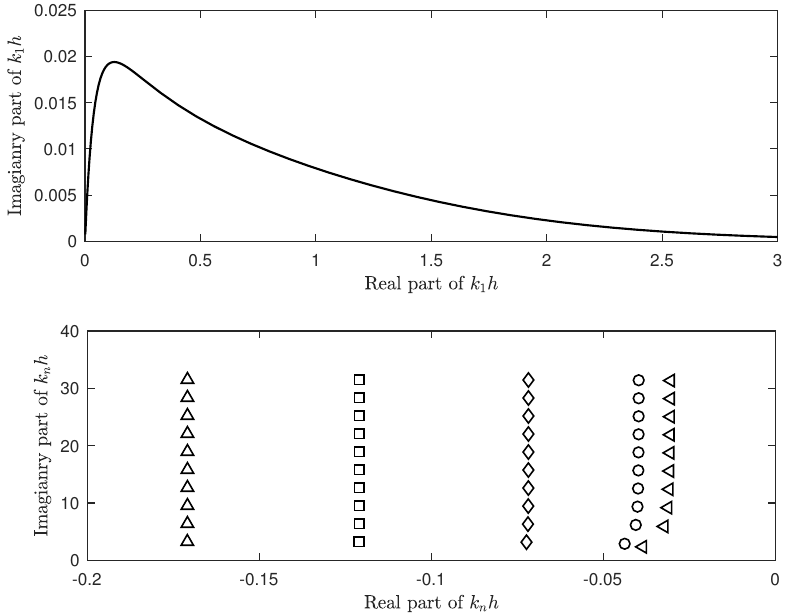
Figure 2. Wavenumbers for Region 1 and Region 3. Top: propagation mode, k 1 . Bottom: examples of the evanescent mode, k n = 2 ∼ 11 , corresponding to (cid:60) ( k 1 h ) = 0.01,0.05,0.25,1,2.5 ( (cid:52) , (cid:3) , (cid:5) , cases, h = 10 m, ρ w / ρ m = 0.9, ν m = 0.01 m 2 /s, and d / δ m =